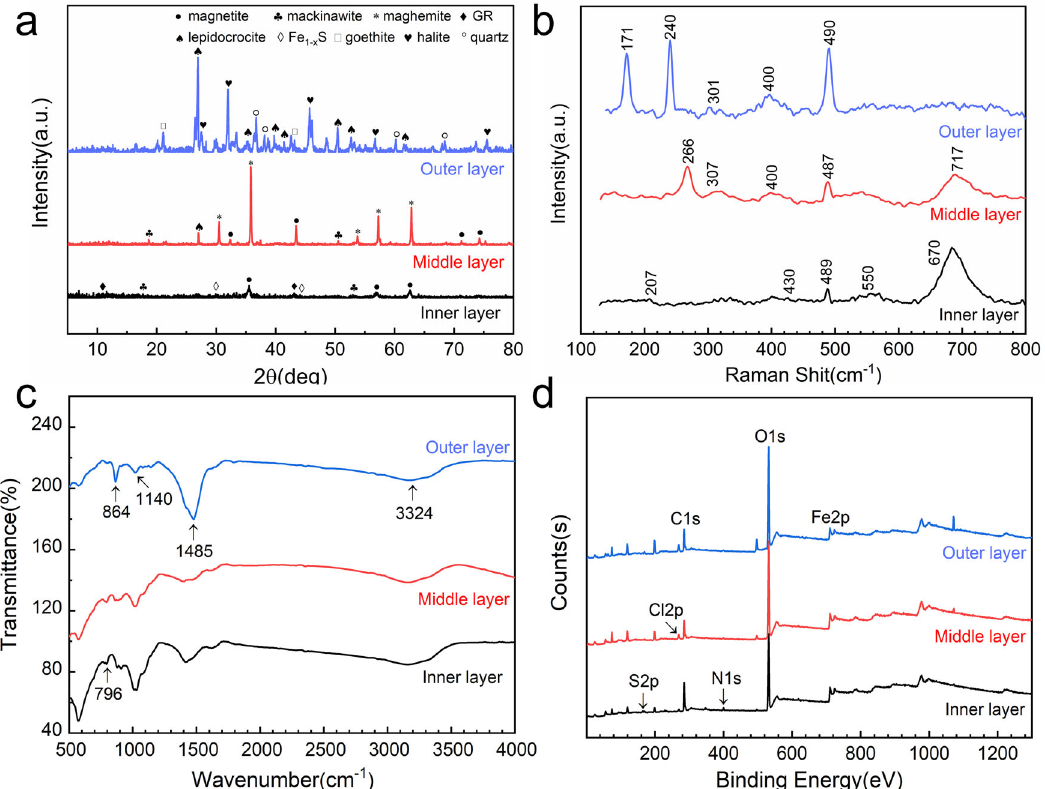
Fig. 3 Composition of the three-rust-layer corrosion products of Q345 steel immersed in nature sea water. a XRD, b Raman, c FT-IR, and d wide-scan XPS